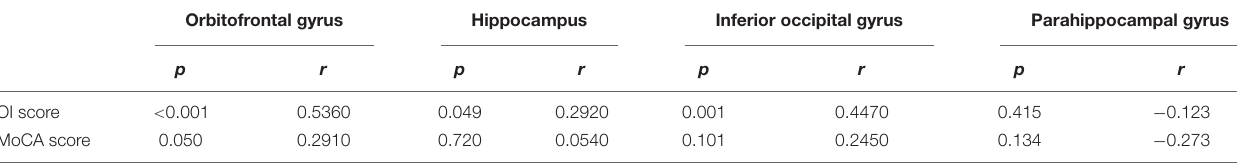
TABLE 5 | Correlation between behavioral indicators and FA values of the ROIs. Orbitofrontal gyrus Hippocampus Inferior occipital gyrus Parahippocampal